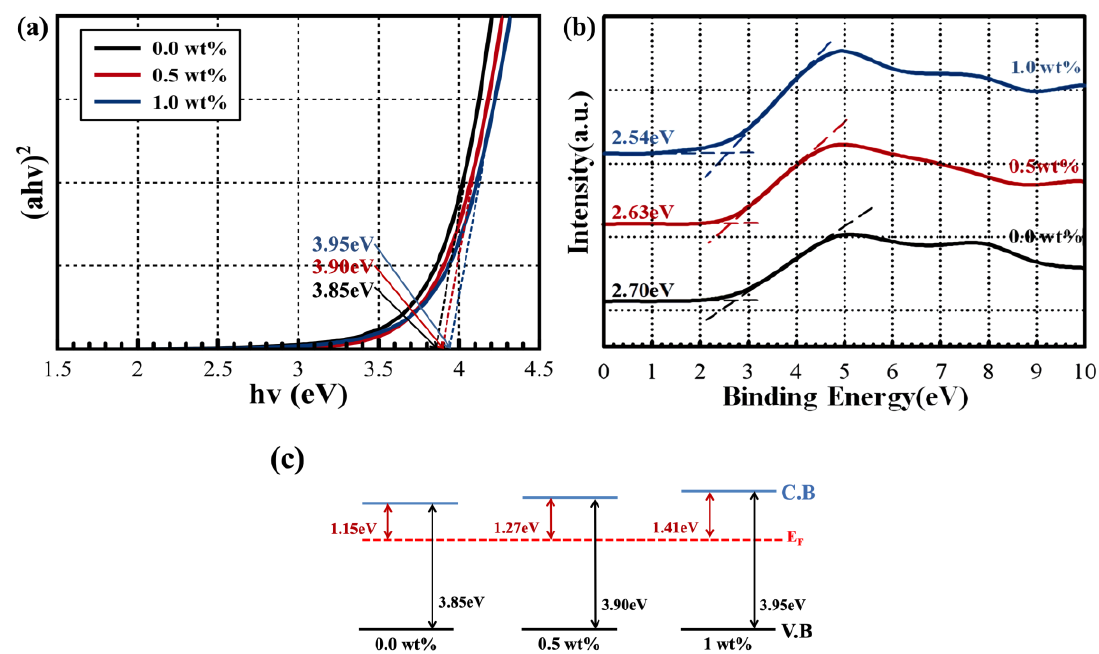
Figure 3. ( a ) Increased optical band gap of the solution-processed SnO 2 films As the doping concentration increases. ( b ) Decreased valence band off set, determined by XPS spectra near the valence band. ( c ) Schematic energy band diagram including the relative energy position of the Fermi level with respect to the conduction band minimum and the valence band maximum.